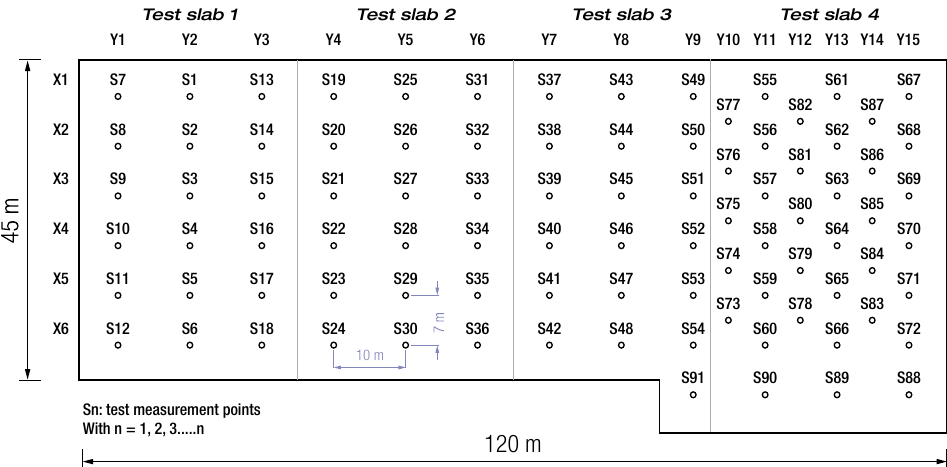
Figure 4. Geometry of the survey grid and PANDA test points. DS slope embankment of classified sand tailings dam